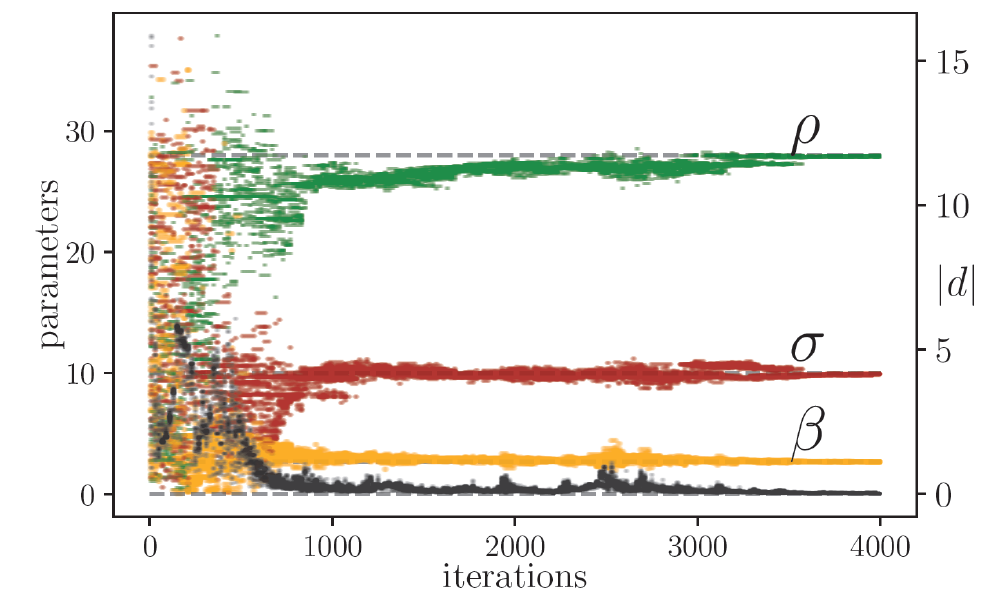
Figure 8. The distance between variables (black points, right axis) and parameters (color points, left axis) as a function of iterations (repetitions times number of samples of a trajectory) with the pruned-enriching method for 50 randomly selected replicas of the h = 10,000 used to estimate the parameters. We used d t = 10 − 2 , τ = 0.2 and T = 100, so the number of samples (time series) of a trajectory is 500, and we show M = 8 iterations. We consider the situation where only measurements in the coupling direction C = [ 1,0,0 ] are available at every k = 20 temporal steps d t , and we used an embedding space of dimension d e = 5.